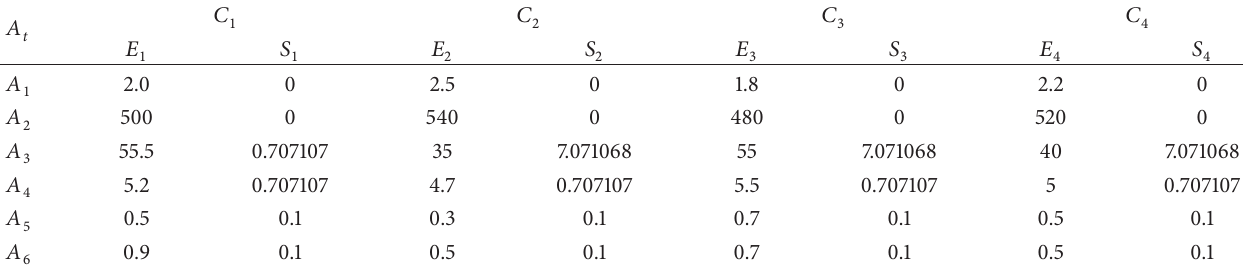
Table 2: The average value and the standard deviation of every index.